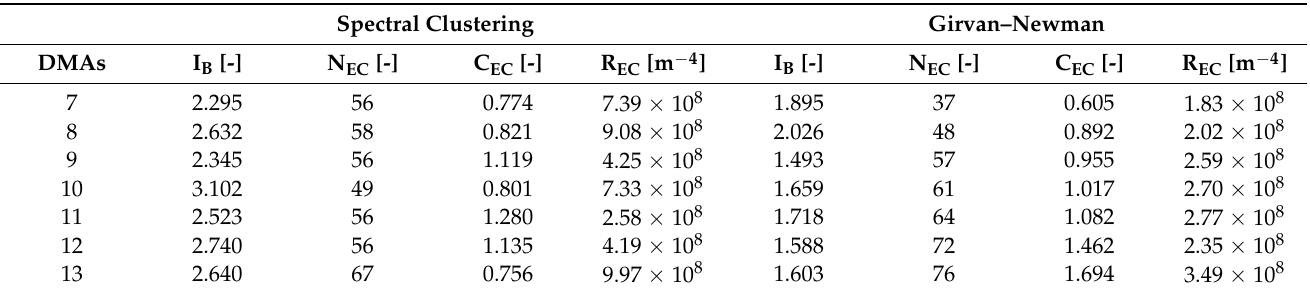
Table 2. Number of edge-cuts, clustering, and hydraulic indices for spectral clustering and Girvan– Newman